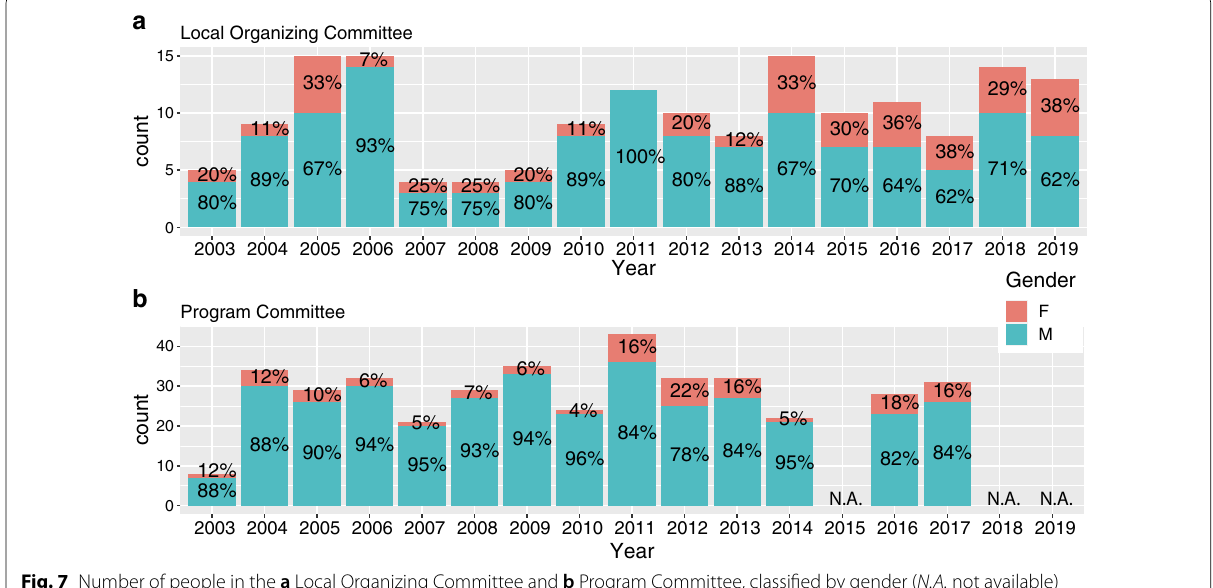
Fig. 7 Number of people in the a Local Organizing Committee and b Program Committee, classified by gender ( N.A. not available)